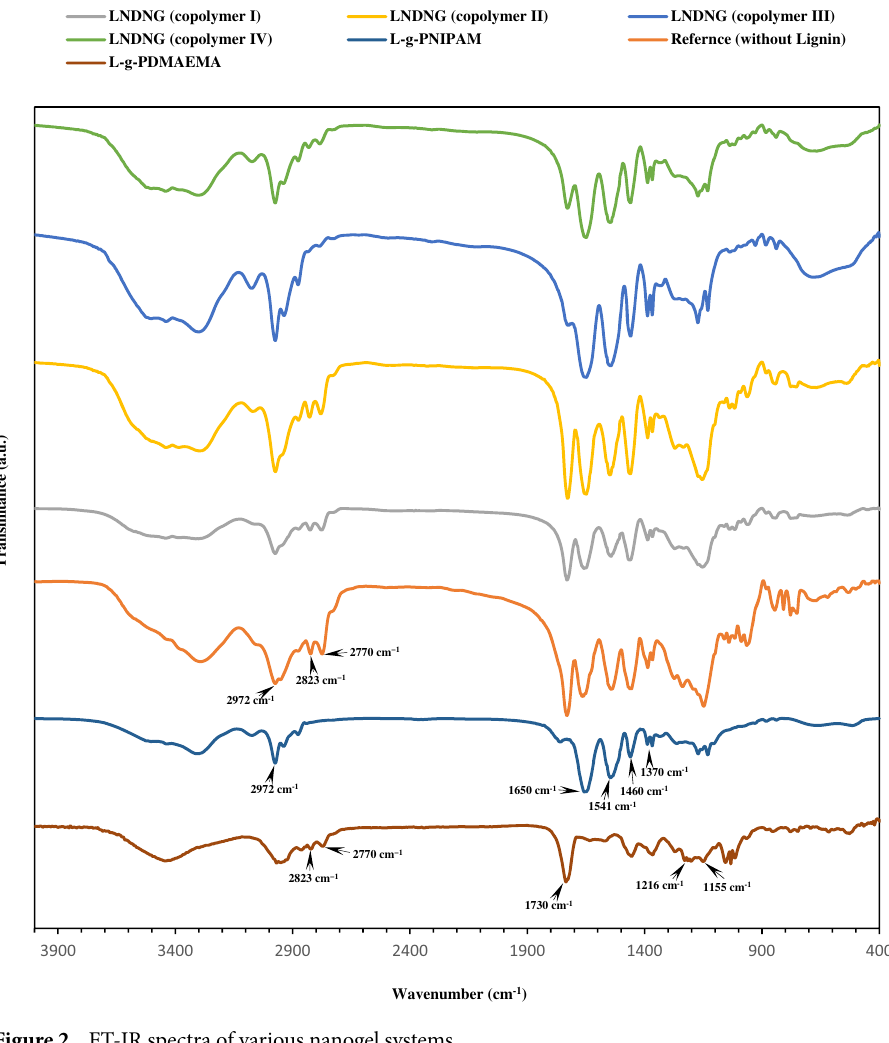
Figure 2. FT-IR spectra of various nanogel